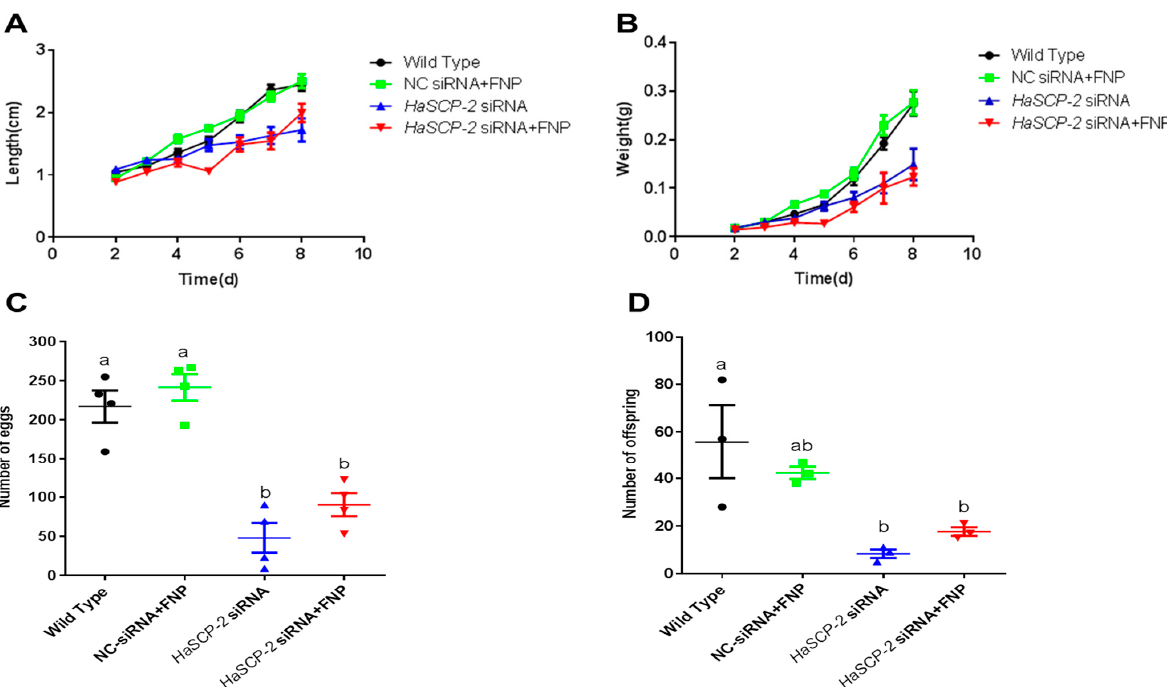
Figure 9. Life cycle analyses. ( A ) Analysis of average larval body length from day 2 to 8 post RNAi. ( B ) Analysis of average larval body weight from day 2 to 8 post RNAi. ( C ) Number of eggs. ( D ) Number of offspring. Data are mean ± SD. Different letters above bars indicate that the mean values differ from each treatment significantly ( p < 0.05, Tukey’s HSD multiple test) between the different